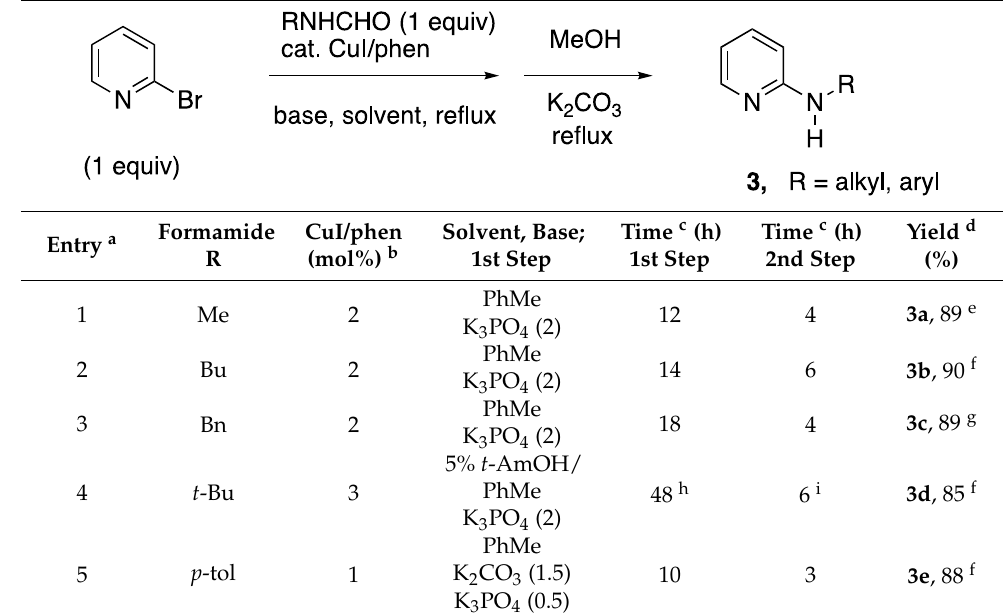
Table 2. One-pot Synthesis of 2-Alkyl(aryl)aminopyridines from 2-Bromopyridine and Secondary Formamides.